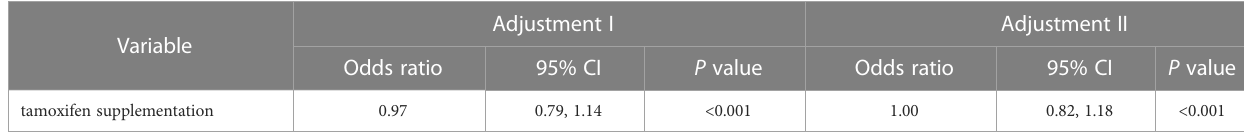
TABLE 2 Multivariate analysis for the effect of tamoxifen supplementation on the endometrial thickness between the TMXF-HRT group and control group.